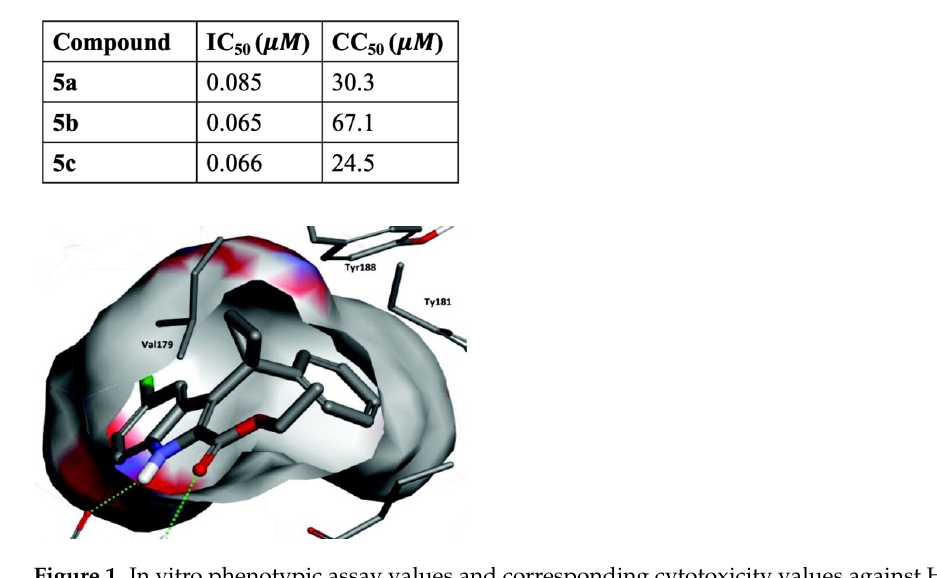
Figure 1. In vitro phenotypic assay values and corresponding cytotoxicity values against HIV. The molecular docking study of 5a in the binding site of HIV reverse transcriptase [18].